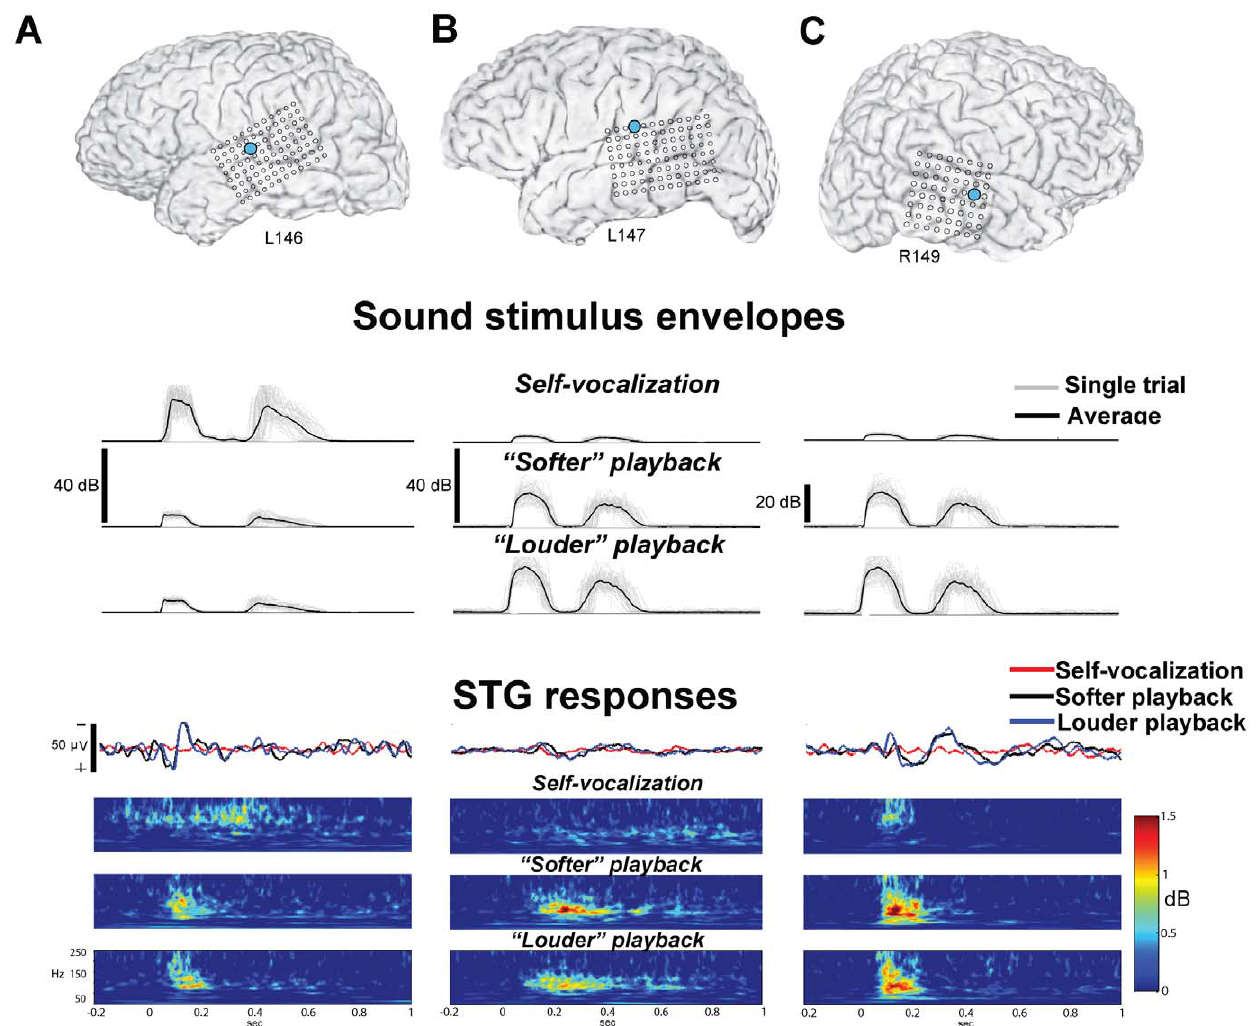
Figure 1. Vocalization-associated changes in auditory responses are not significantly altered by changes in PB intensity. Different intensities of the PB stimuli were tested in the three subjects shown. Each vertical column displays a recording site location (top, filled blue circle), sound stimulus envelope tracings (middle) and the evoked responses recorded from the selected recording site (bottom) for each subject. (A) Subject 146 perceived the PB stimuli to be both ‘‘softer’’ and ‘‘louder’’ than the SV stimuli despite the fact that the sound stimulus envelope was smaller at both PB intensities than those measured during SV. The AEP waveform is nearly identical for the ‘softer’ and ‘louder’ PB stimuli, and is completely attenuated during SV. The high-gamma (HGB) response shows a ‘sustained’ pattern during SV, and an ‘on’ pattern during both PB conditions, with the early HGB increase seen during PB to be attenuated during SV. Subjects 147 (B) and 149 (C) both perceived the PB stimuli to be both ‘‘softer’’ and ‘‘louder’’ than the SV stimuli yet for these subjects the measured sound stimuli envelopes were greater for both PB intensities compared to